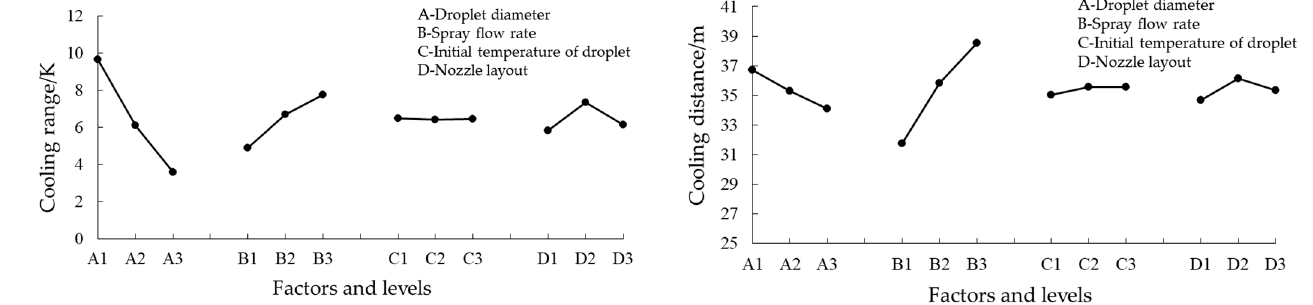
Figure 13. The influence trend chart of various factors on the cooling coverage and cooling distance.